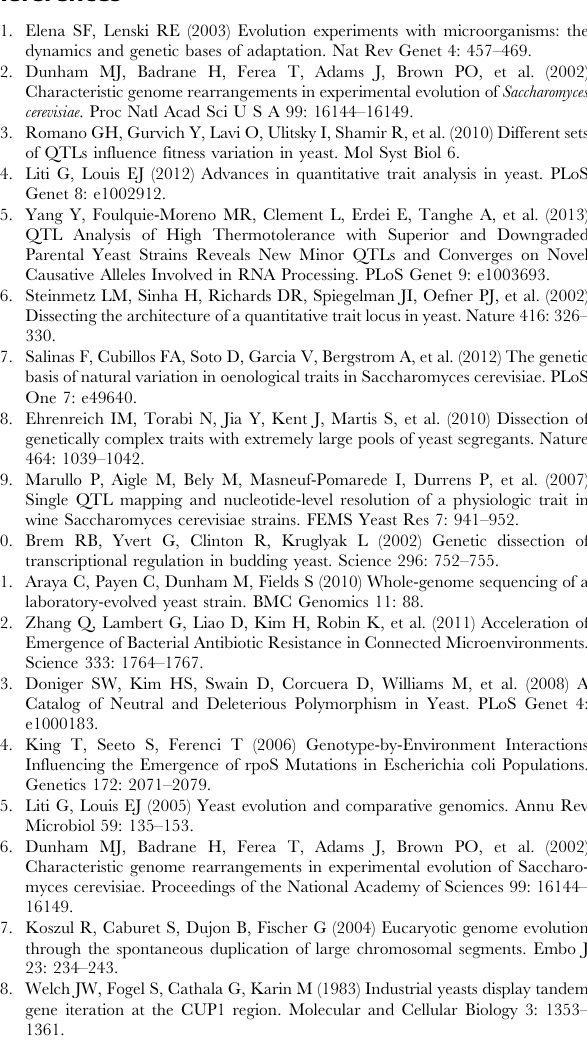
( YOL089c ) respectively. The lag phase time computed is indicated by a red arrow. Figure S2 Reciprocal heterozygosity analysis of ATG34 and HAL9 for lag phase. The lag phase (h) as well as the LP viability was measured for parental strains (SB and GN), F1 hybrid (BN) as well as hemizygous hybrids (G083S, S083G, G089S,S089G) for genes ATG34 (YOL083w) and HAL9 (YOL089c). The bar plots represent mean values and standard errors measured for 3 independent repetitions. The statistic difference between isogenic strains was tested using a Wilcoxon test. Isogenic strains are represented with the same color, GN = light green, BN= green, SB= blue. The significant levels was coded *, and **, for p-values , 0.05 and , 0.01 respectively.